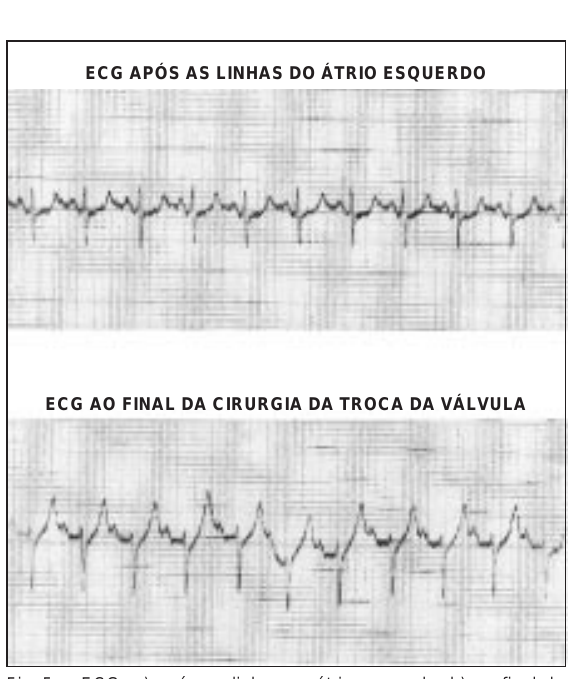
Fig. 5 - ECG. a) após as linhas no átrio esquerdo; b) ao final da operação da troca da